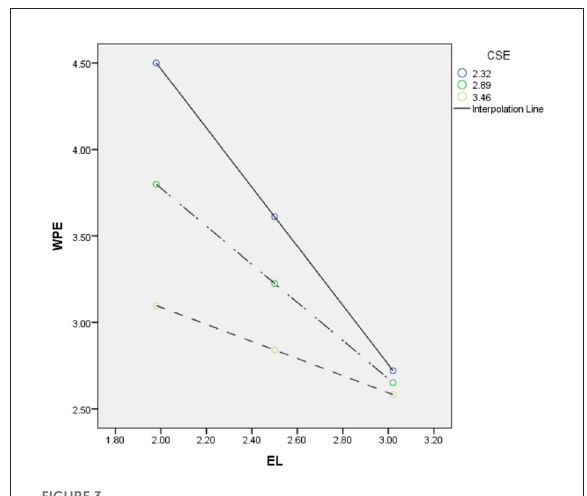
FIGURE3 Regression results for the conditional indirect